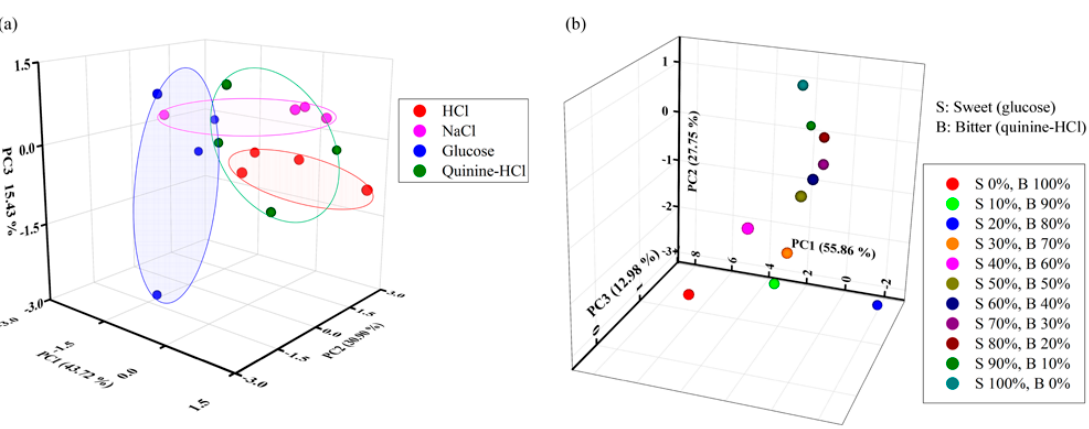
Figure 14. PCA results for the dataset obtained by sensing mixed taste solutions with the designed IDC electronic tongue: ( a ) mixture of four different taste solutions (HCl, NaCl, glucose, and quinine-HCl) and ( b ) different percentages of mixed glucose and quinine-HCl solutions.